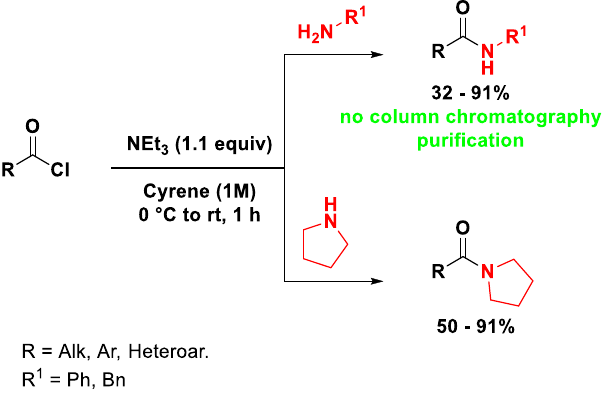
Scheme 2. Synthesis of amides from acid chlorides in Cyrene.